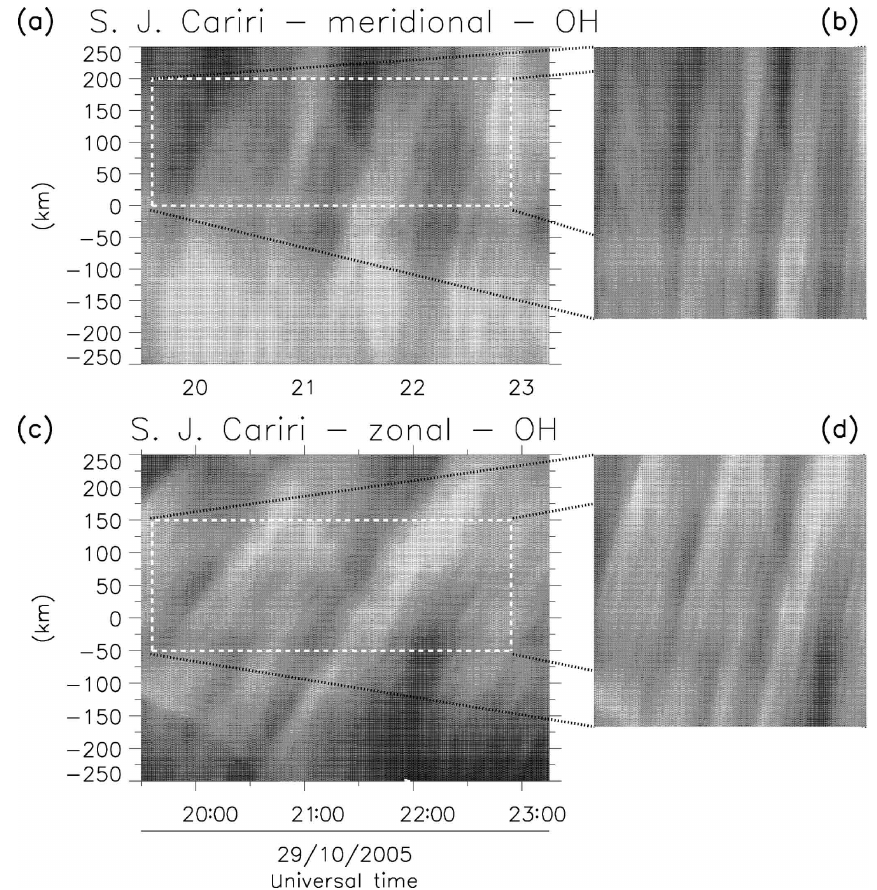
Figure 3. Keograms created from a sequence of images observed on the night of 29 October 2005 (MSGWs appear as a coherent, tilted band). The panels (a) and (c) are the meridional and zonal components of the keogram, respectively, while panels (b) and (d) present the regions of interest.